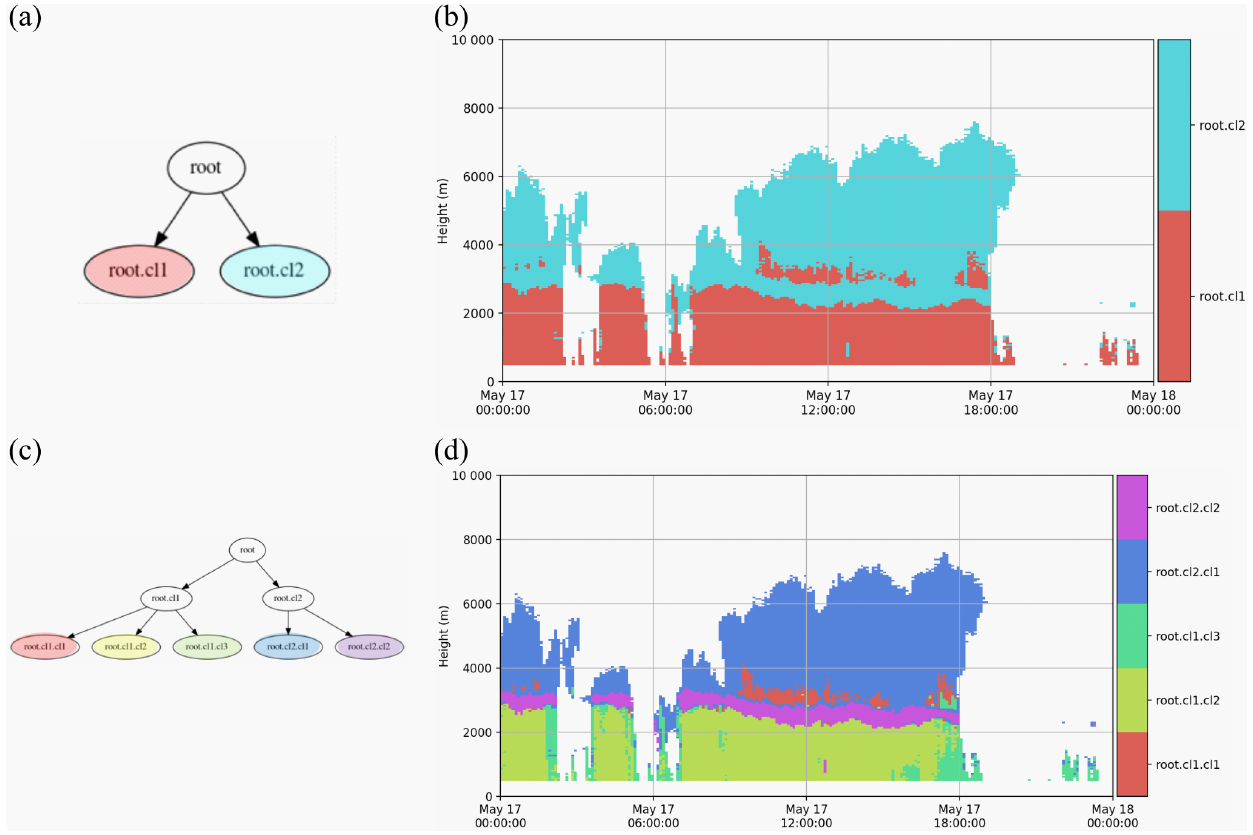
Figure 4. The active clusters at the end of the first (a, b) and second (c, d) cycle of the outer loop of the hierarchical clustering algorithm. Panels (a) and (c) are plotted in the hierarchical (tree) structure, and panels (b) and (d) are plotted in height vs. time format of the observations on 17 May